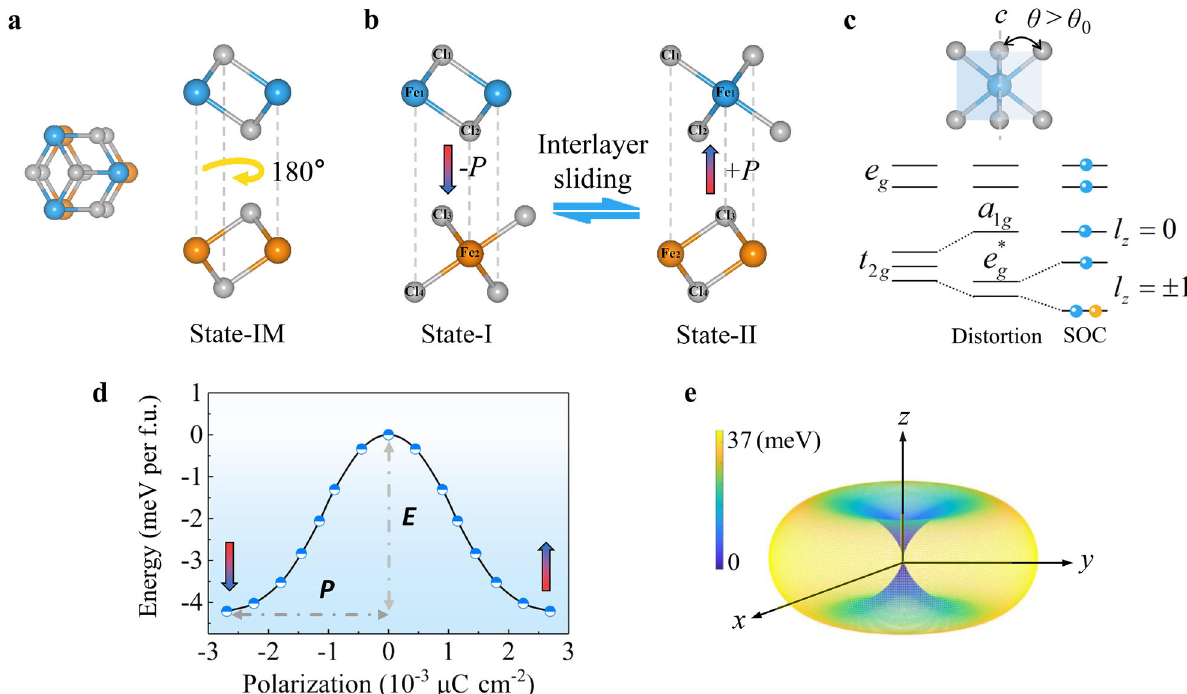
Fig. 2 Basic physical properties of bilayer T-FeCl 2 . Crystal structures of bilayer T-FeCl 2 in a state-IM, b state-I and state-II. c Crystal fi eld splitting of the Fe-d orbitals. Top panel in c shows the distorted octahedral geometry. d Energy barrier of ferroelectric switching from state-I to state-II. e Spherical plot of MAE arises from rotating the spin axis from the easy axis in bilayer T-FeCl 2 . The MAE is set to zero in the out-of-plane